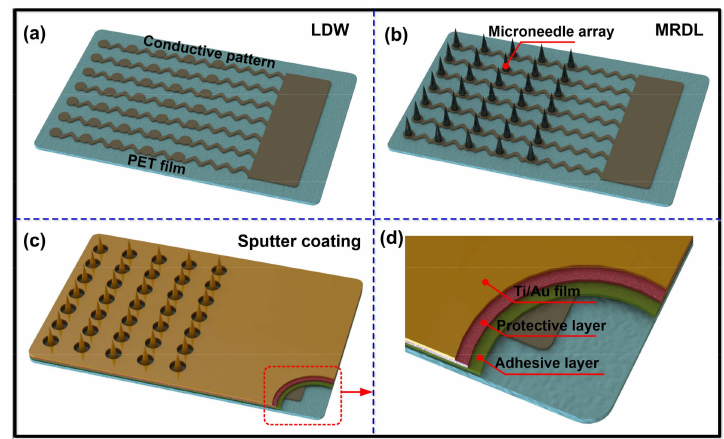
Figure 1. Schematic diagram of flexible MAE fabrication process. ( a ) Conductive pattern fabricated by LDW, ( b ) Microneedle array fabricated by MRDL, ( c ) Ti/Au layer coating, ( d ) The schematic of flexible